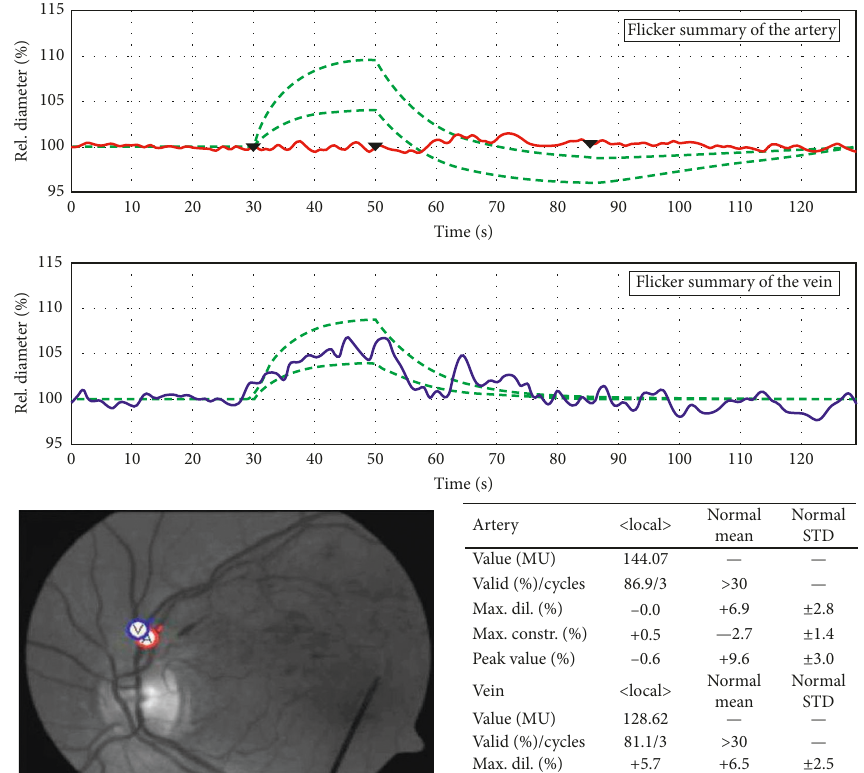
Figure 1: Dynamic vessel analysis of patient #3 with macular edema secondary to BRVO. In patients with RVO, arterial and venous segments were chosen and marked with a probe (red for the artery and blue for the vein) (bottom left) to evaluate the arterial (first row) and venous (second row) flicker